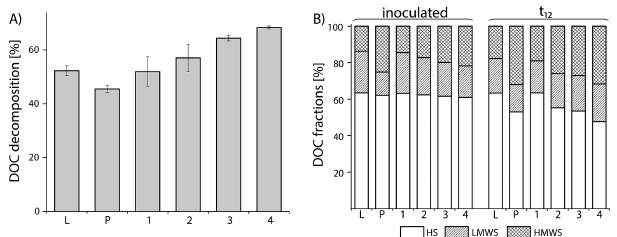
Fig. 3. Percentage of DOC decomposed (A) and inoculated and fi- nal ( t 12 ) dissolved organic carbon (DOC) fractions (B) in leachate (L) and phytoplankton (P) single incubation and mixed treatments (1–4). According to Huber et al. (2011) the fractions are humic-like substances and building blocks (HS), low-molecular-weight sub- stances (LMWS), and high-molecular-weight substances (HMWS). In A we plotted the mean ± standard deviation for the DOC decom-